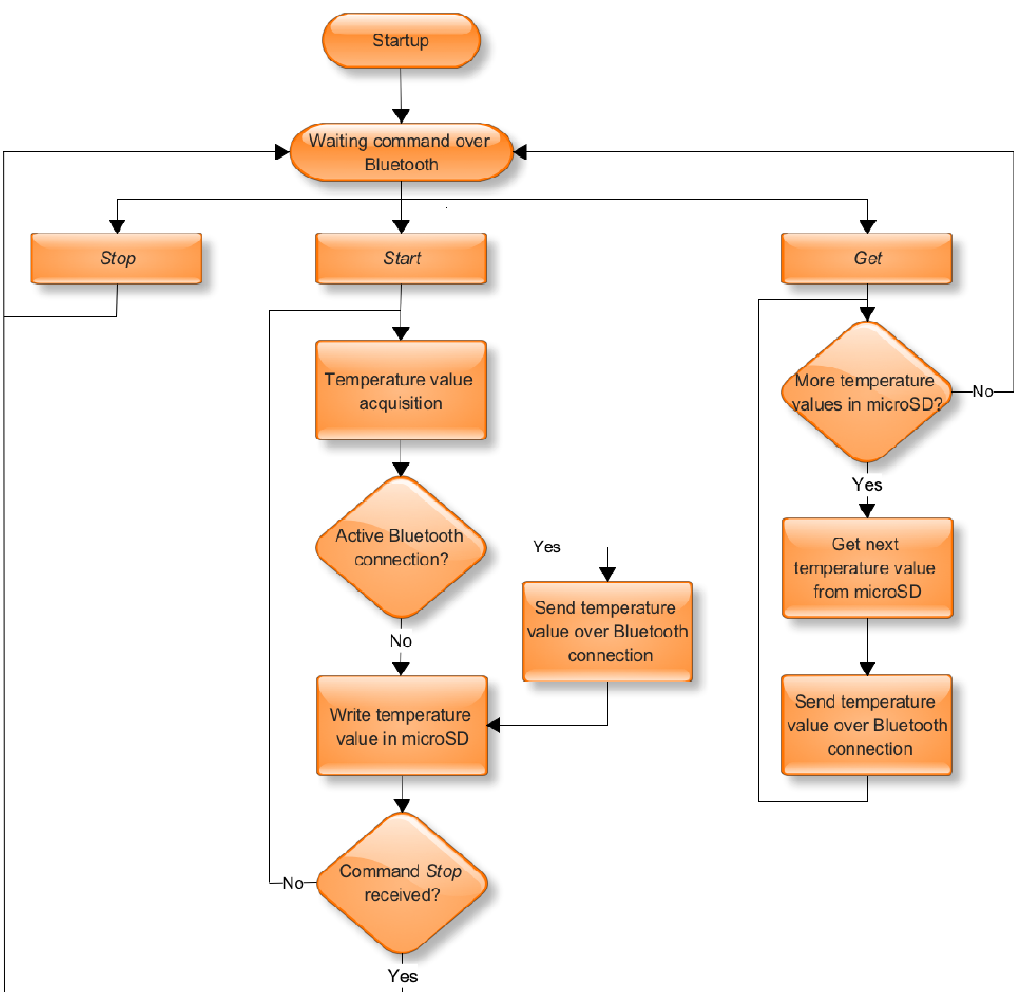
Figure 5. SHIMMER firmware